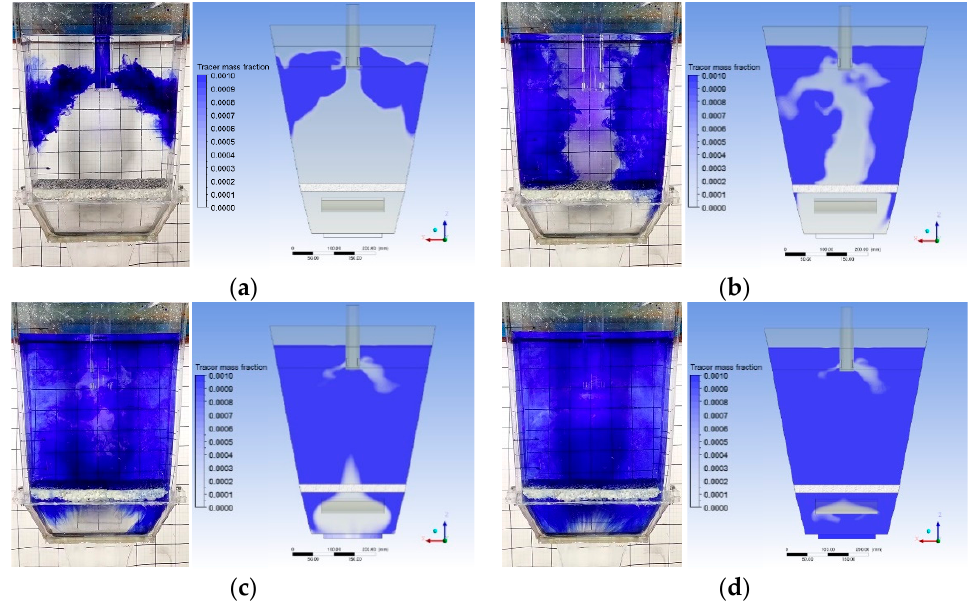
Figure 4. Comparison of tracer behaviors between physical modeling and mathematical modeling. ( a ) 5 s, ( b ) 15 s, ( c ) 25 s, ( d ) 35 s.